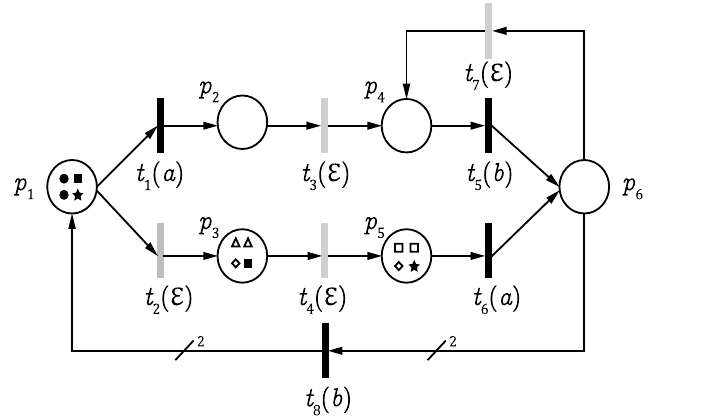
Figure 5. Observer net (cid:31) with an initial state M (cid:31) ,0